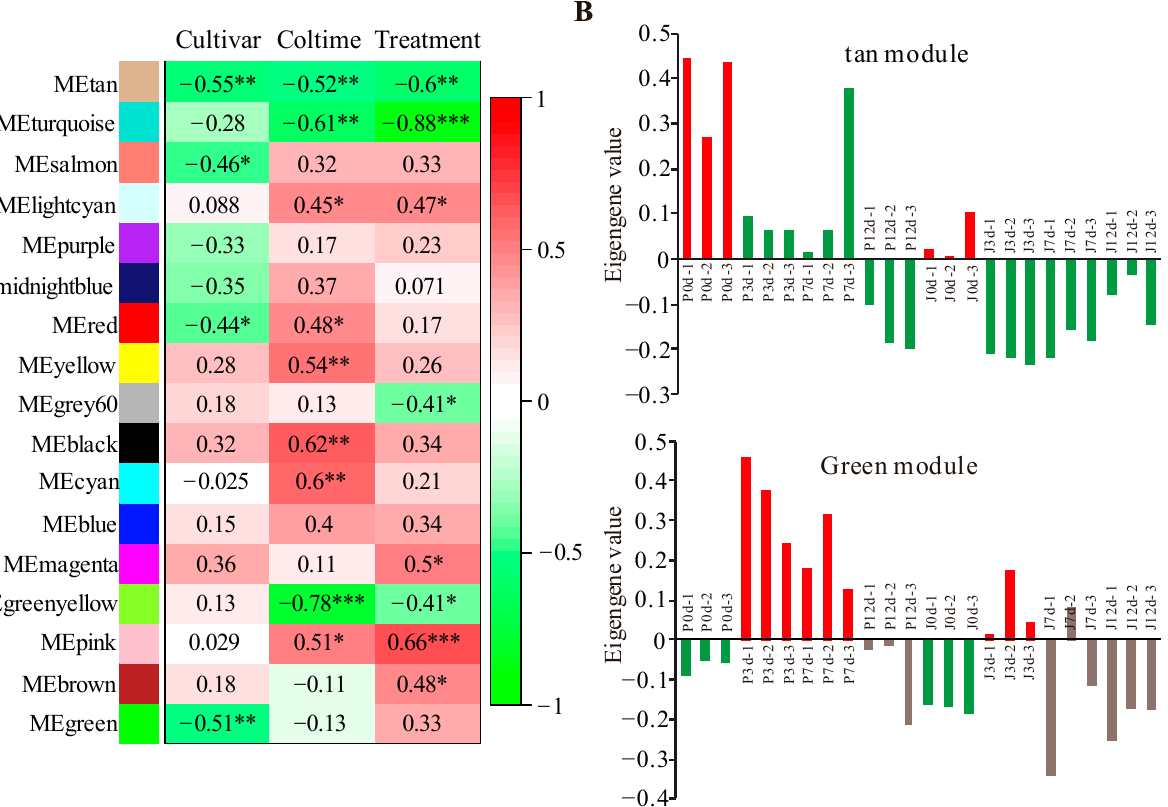
Figure 4. Identification of statistically significant modules. ( A ) Relevance between modules and traits. Numbers in the heatmap indicate correlation coefficients. * indicates p < 0.05. ** suggests p < 0.01. *** represents p < 0.001. Coltime is the abbreviation of collection time. ( B ) The eigengene expression values of tan (top) and green (bottom) modules. P0 to P12 indicates ‘Pawnee’ expressions at 0 to 12 days after grafting. J0 to J12 indicates ‘Jinhua’ expressions at 0 to 12 days after grafting.